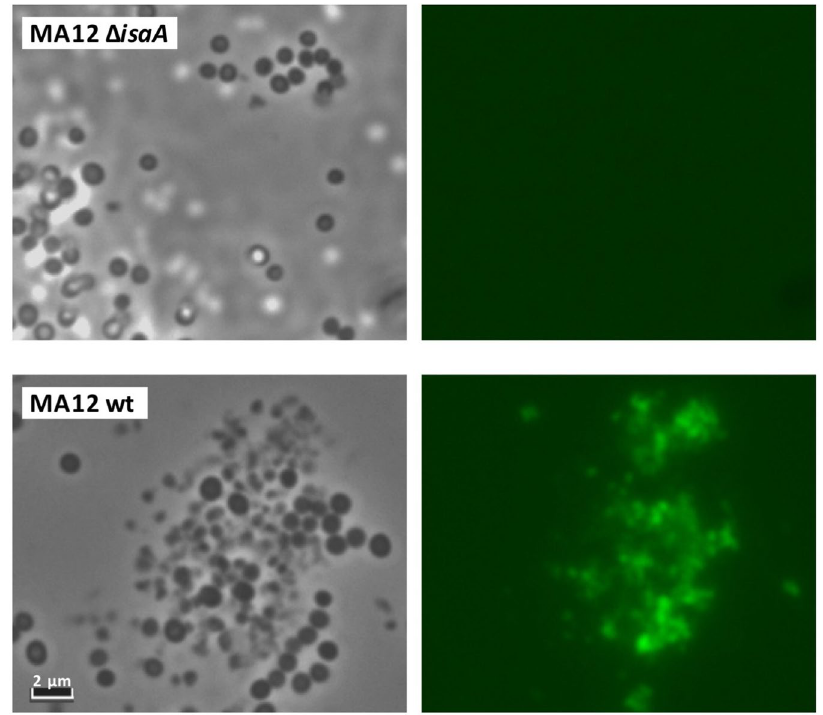
Figure 3. Exposure of IsaA on the S . aureus cell surface. Phase contrast (left panels) and near-infrared fluorescence (right panels) microscopic images of overnight cultured S . aureus cells treated with 1D9 F(ab) 2 - 800 CW. Top panels, S . aureus MA12 Δ isaA cells; bottom panels wild-type (wt) S . aureus MA12